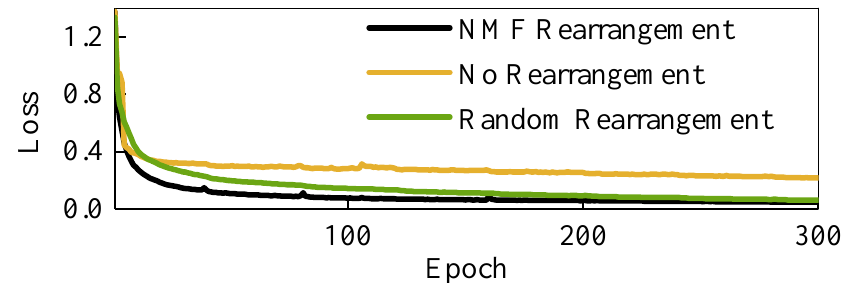
Figure 9. Changes of loss with proposed and two comparative convolutional autoencoder architec- tures. NMF rearrangement means the muscle channel of the sEMG image is rearranged according to the muscle synergy trick. No rearrangement means the muscle channel of the sEMG image does not rearrange. The random rearrangement means the muscle channel of the sEMG image is rearranged but rearrangement